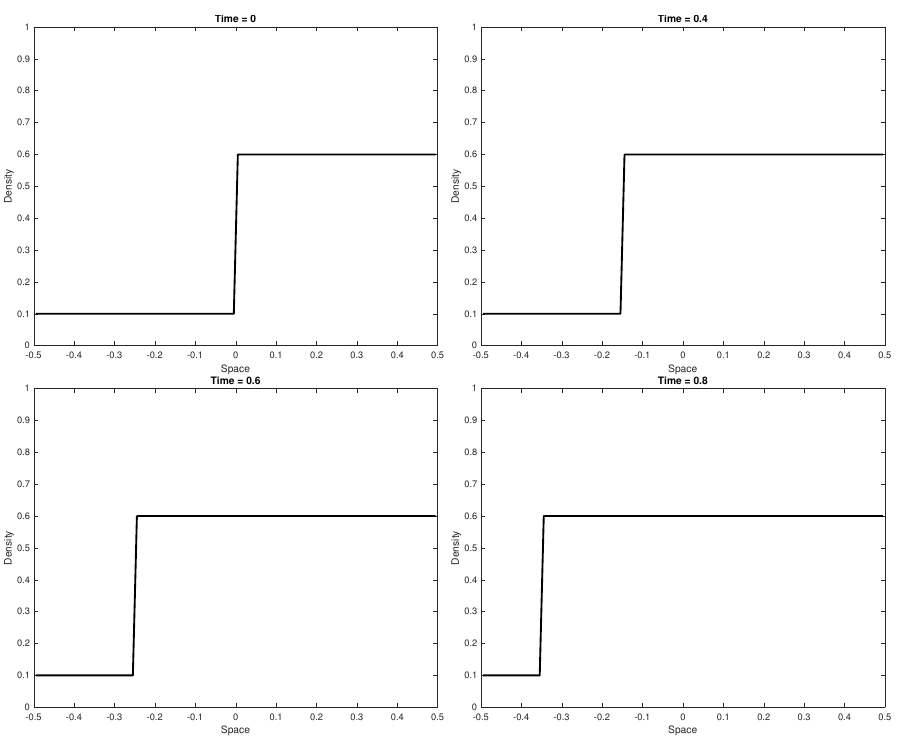
Figure 6. Evolution of the density for a classical phase transition model on a single